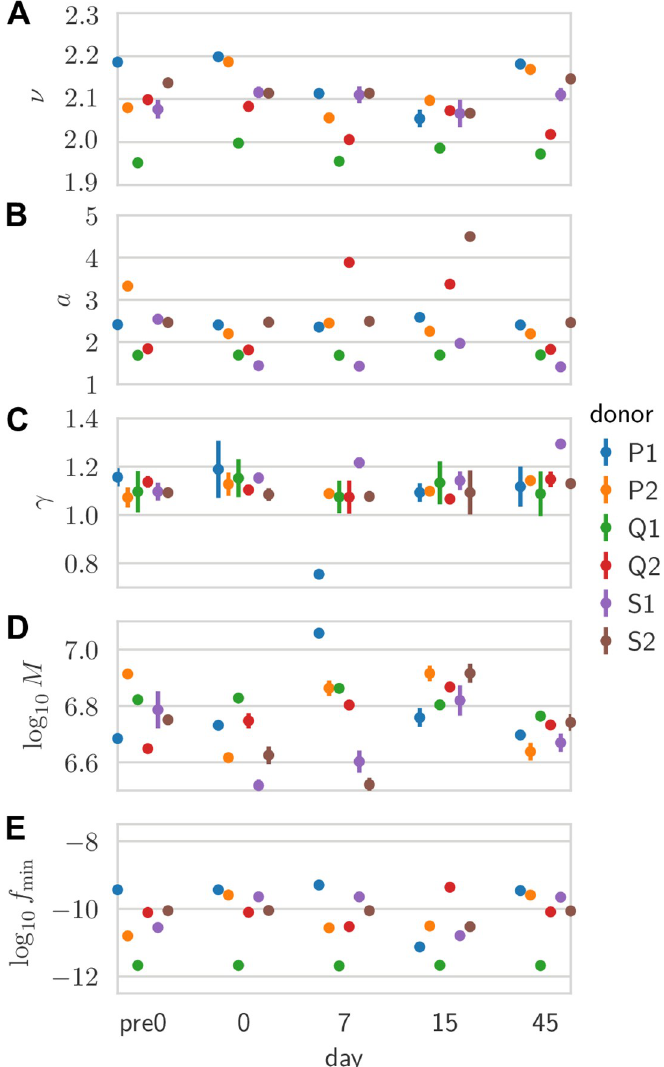
Fig 4. Inferred null model parameters. Inferred values: for (A) the power-law exponent ν of the clone size distribution; (B) and (C) linear coefficient and exponent of the mean-variance relationship of the noise; (D) effective number of cells; and (E) minimal clonal frequency. Each point is inferred from a pair of replicates for a given donor and time point. Error bars are obtained by inverting the Hessian of the log-likelihood projected onto the hyperplane locally satisfying the normalization constraint (error bars smaller than symbols not